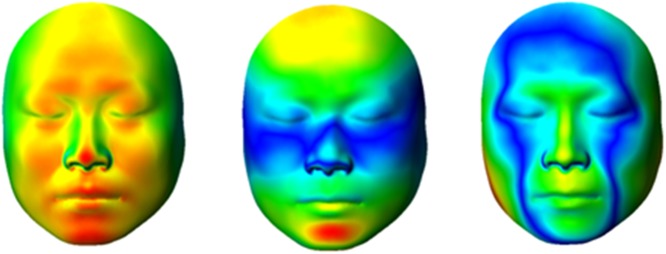
Reflected region by PCA principal component.